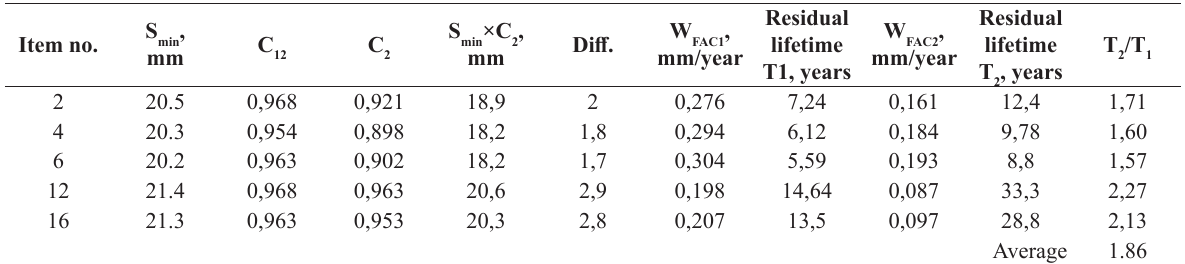
Table 6. Values characterizing residual lifetime of WZ outlet of pressure pipelines of feed electric pump and emergency feed pumps 426 × 24 mm. Item no.